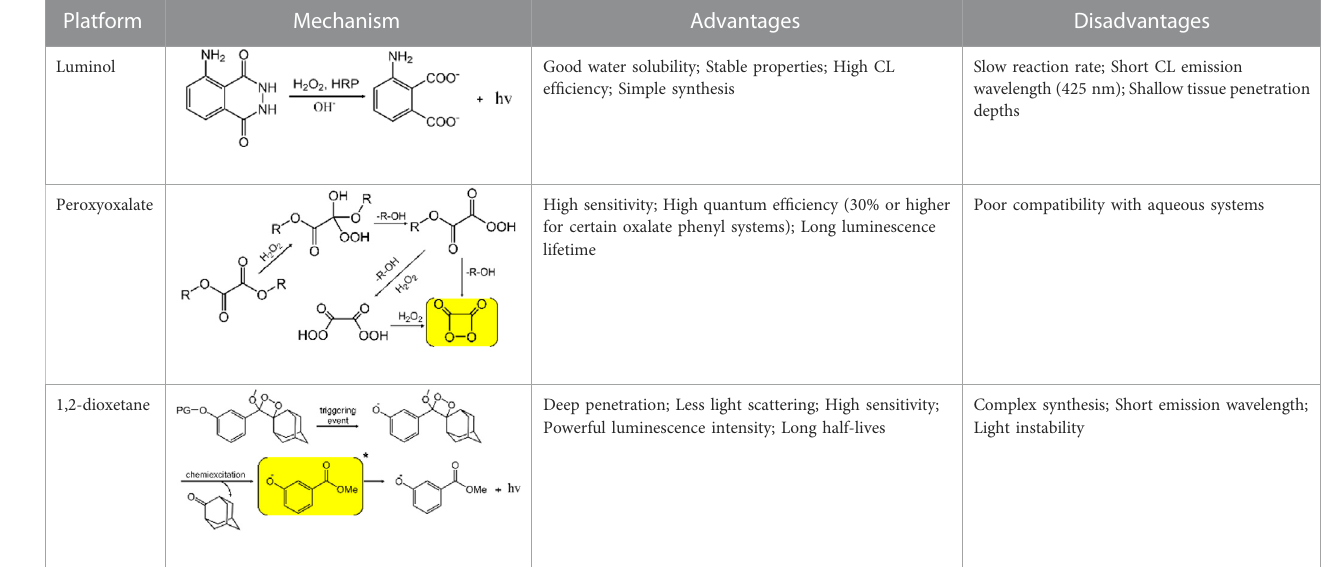
TABLE 1 Overview of three chemiluminescent substrates.